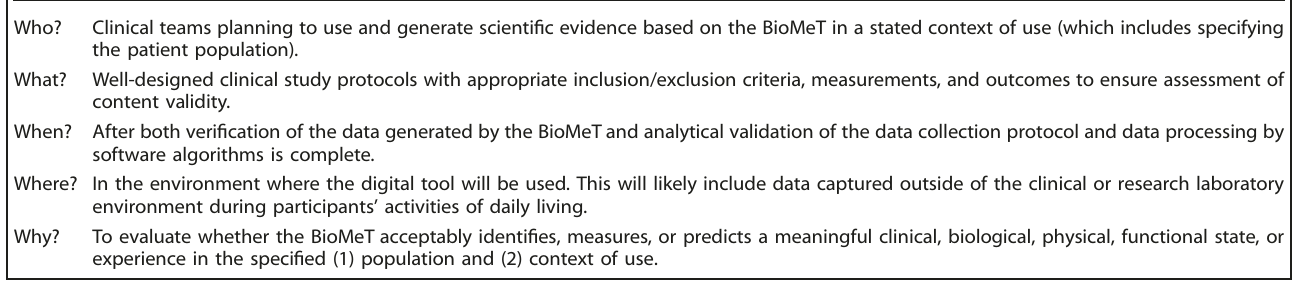
Table 7. Clinical validation in